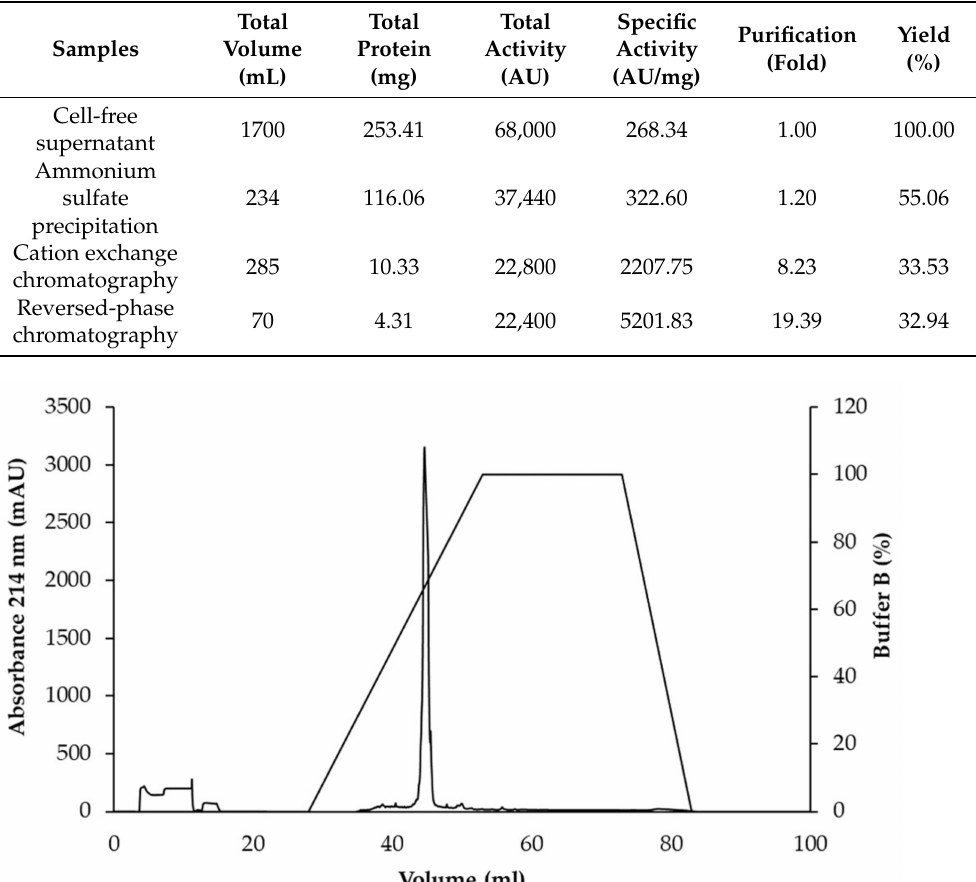
Table 2. The purification balance sheet of an antimicrobial substance from WUL10.